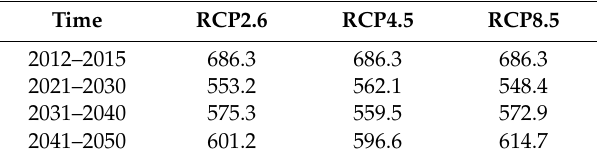
Table 6. Decadal changes of the maize CWC in the Ganzhou area under the three RCP scenarios (unit: